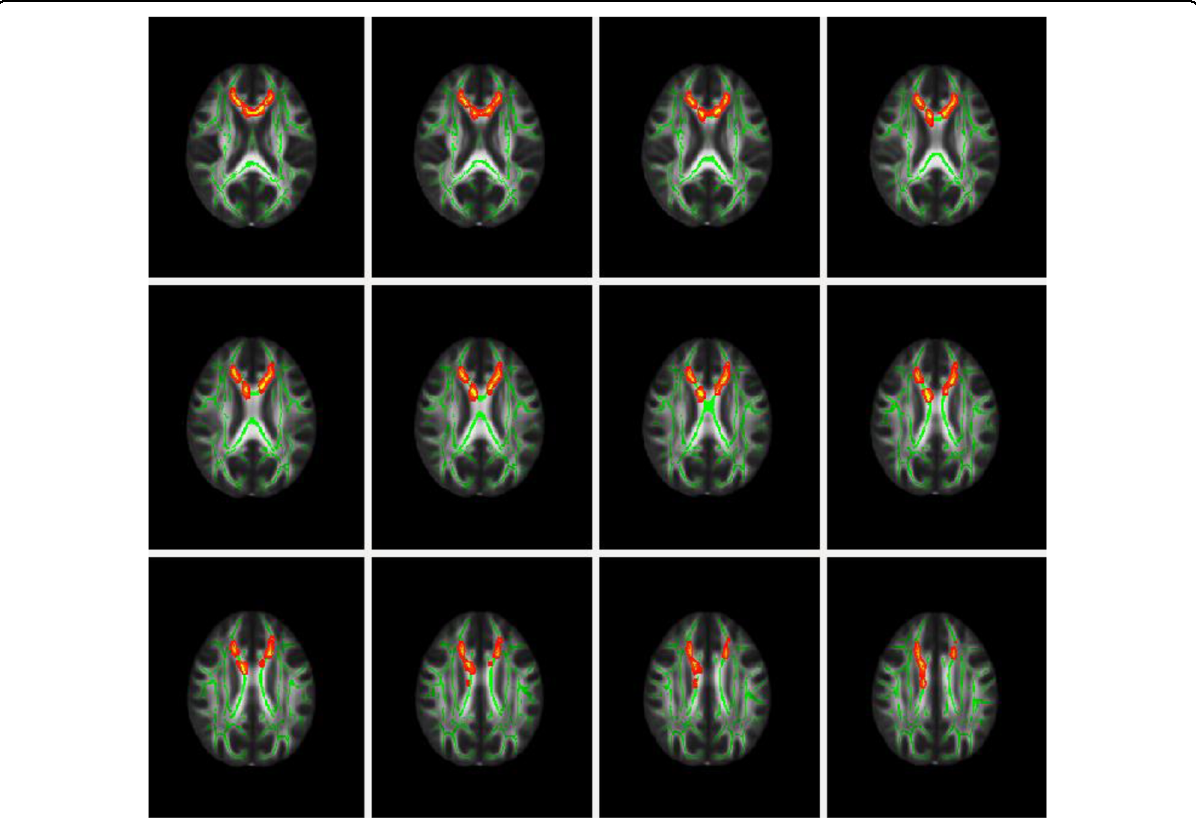
Fig. 2 TBSS between symptomatic offspring of patients with BD and healthy controls. Axial rendering showing signi fi cant difference in symptomatic offspring of patients with BD (SO) compared with health controls (HCs) obtained from Tract-based Spatial Statistic (TBSS) analysis. Signi fi cant increased FA in UHR ( P < 0.05, TFCE) was represented by red and yellow color in genu of corpus callosum, body of corpus callosum, left anterior corona radiata, right anterior corona radiata, left superior corona radiata, and right superior corona radiata. Mean FA skeleton of SO and HCs individuals (green color) was overlaid on MNI FA 1 mm skeleton template. The result was thickened with “ tbss- fi ll ” command provided by FSL. The image follows radiological convention.